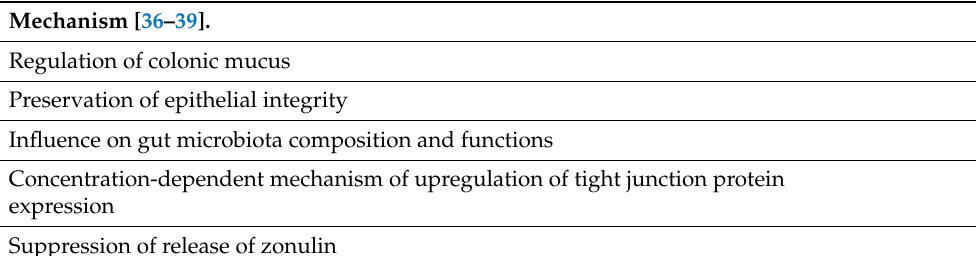
Table 1. Vitamin D mechanisms in preserving the integrity of intestinal epithelial